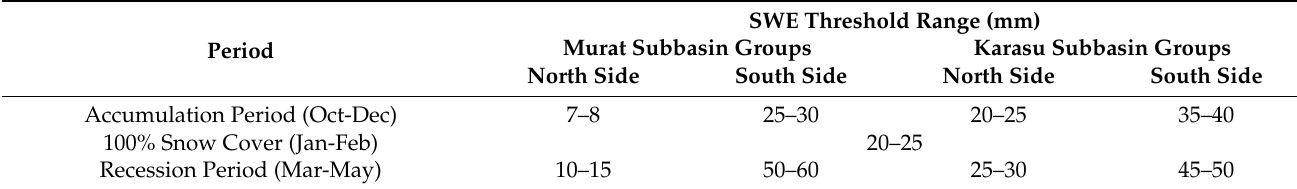
Figure 9. SWAT-MODIS overlapped snow extent visualizations for Murat and Karasu basins using a constant 15 mm SWE-SCA threshold on ( a , b ) 4 December 2005, ( e , f ) 8 April 2006, and using variable SWE-SCA values on ( c , d ) 4 December 2005, ( g , h ) 8 April 2006. Table 10. SWE-SCA threshold ranges of subbasin groups for each